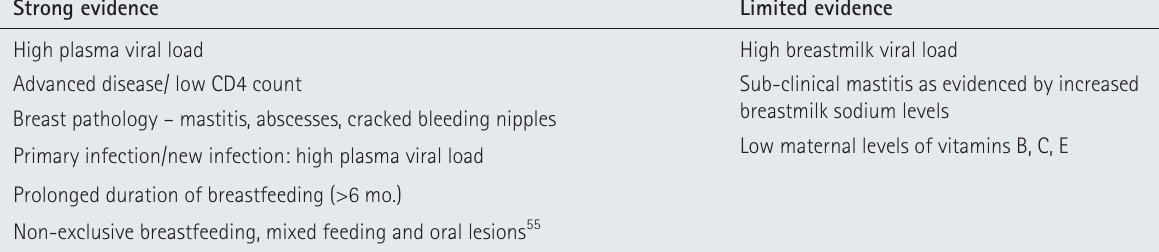
breastmilk sodium levels